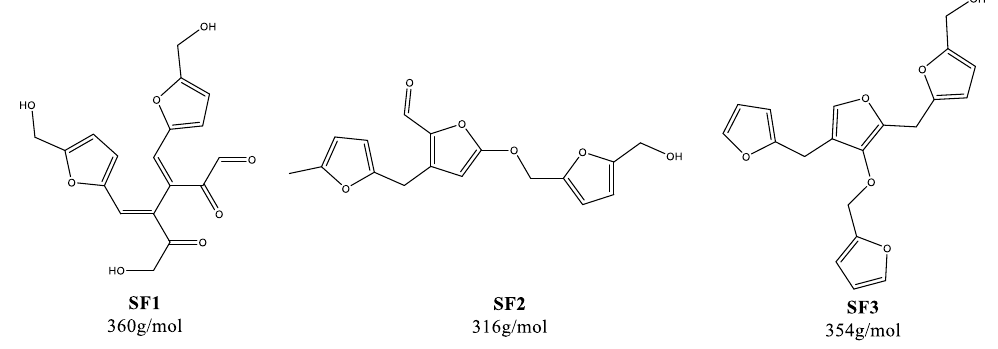
Figure 6. Postulated humin fragments based on mass spectra.